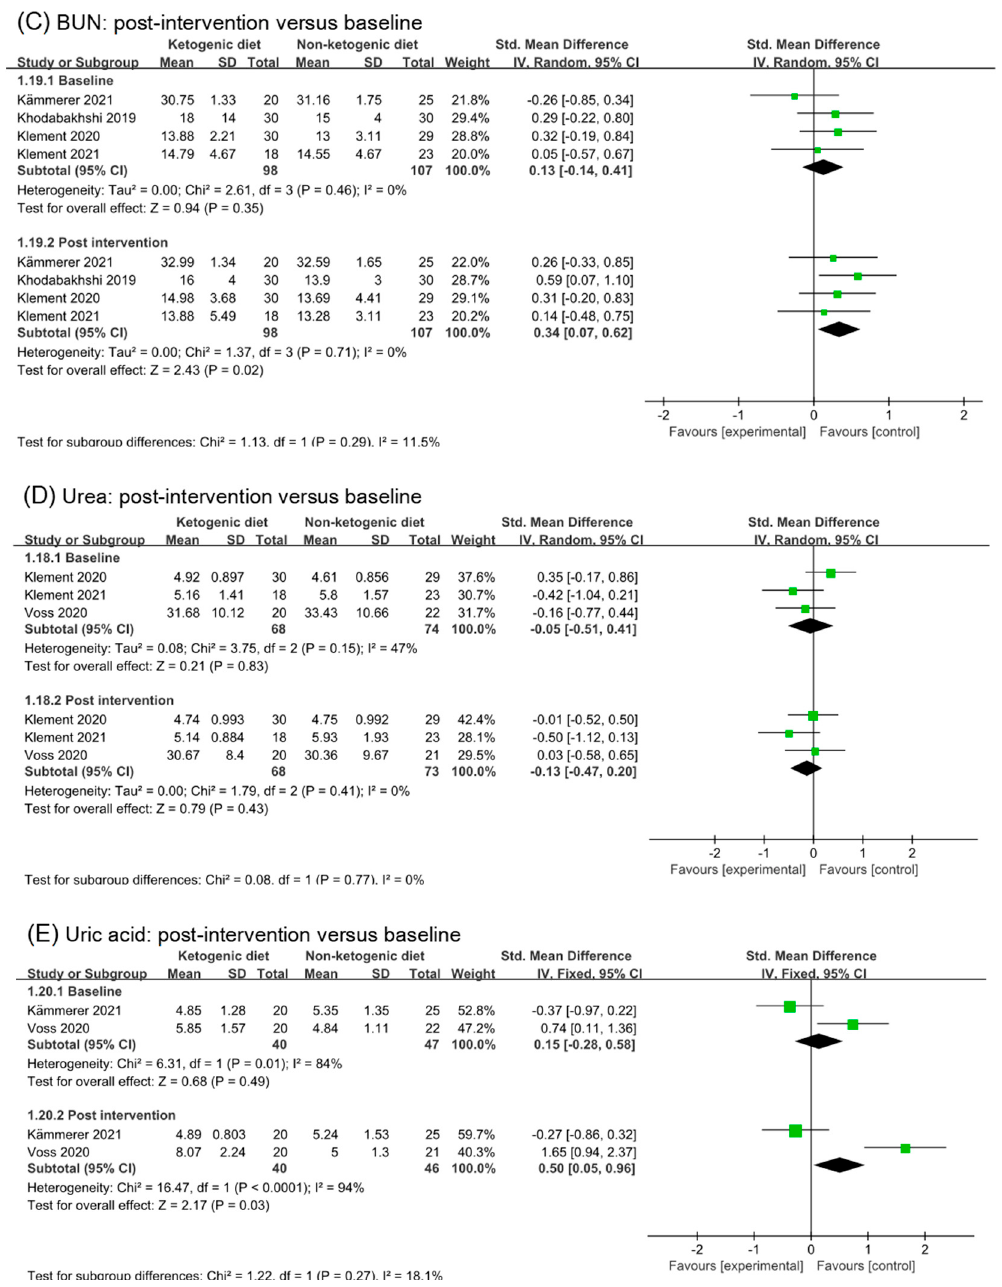
Figure 7. Forest plot for the effects of ketogenic diets on renal function. ( A , C – E ) were subgroup effects of the baseline versus post-intervention on creatinine, BUN, urea and uric acid; ( B ) was the effect of change from baseline on creatinine [31–33,36–42].